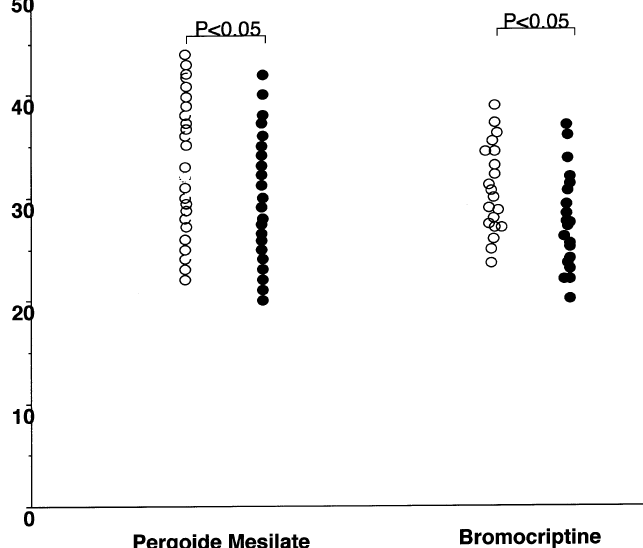
Fig. 2. Zung’s Self Rating Depression Scale (SDS) score comparing those at baseline ( (cid:3) ) and taking pergolide mesilate (left) or bromocriptine ( • ) (right). Neither patients group showed significant improvement in the SDS (from 51.8 ± 11.6 to 49.4 ± 9.8 and form 49.5 ± 4.6 to 45.5 ± 5.6, respectively, NS).